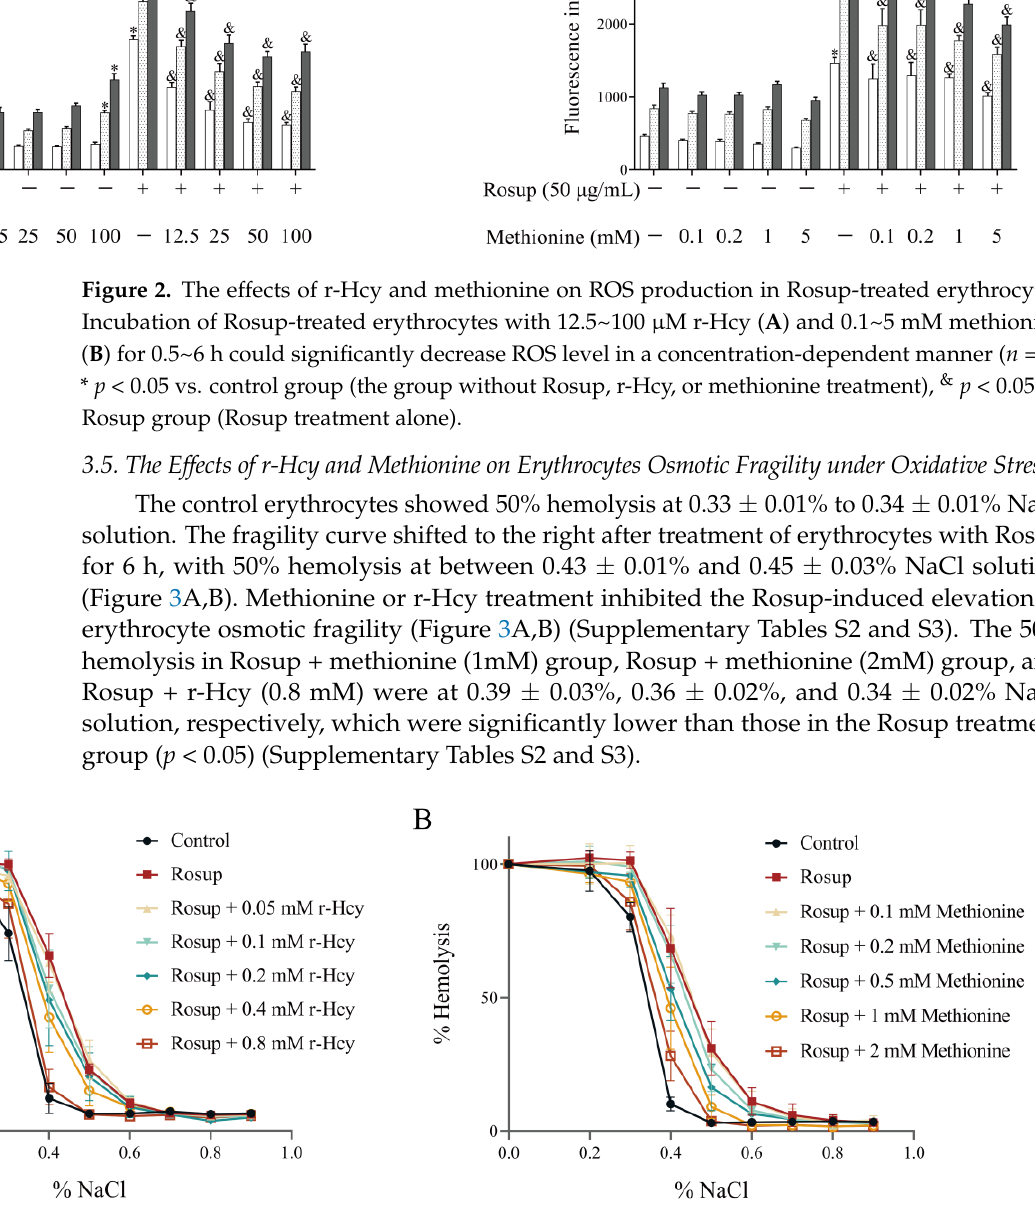
Figure 3. The protective effects of r-Hcy and methionine on erythrocytes osmotic fragility under oxidative stress. ( A ) The fragility curve shifted to the right after treatment of erythrocytes with Rosup for 6 h, with 50% hemolysis at 0.43 ± 0.01% NaCl solution. The 0.05~0.8 mM r-Hcy treatment resulted in the fragility curves of Rosup-treated erythrocytes shifted back to the left. ( B ) The fragility curve shifted to the right after treatment of erythrocytes with Rosup for 6 h, with 50% hemolysis at 0.45 ± 0.03% NaCl solution, and 0.1~2 mM methionine treatment inhibited Rosup-induced erythrocytes osmotic fragility elevation in a dose-dependent manner ( n = 4).